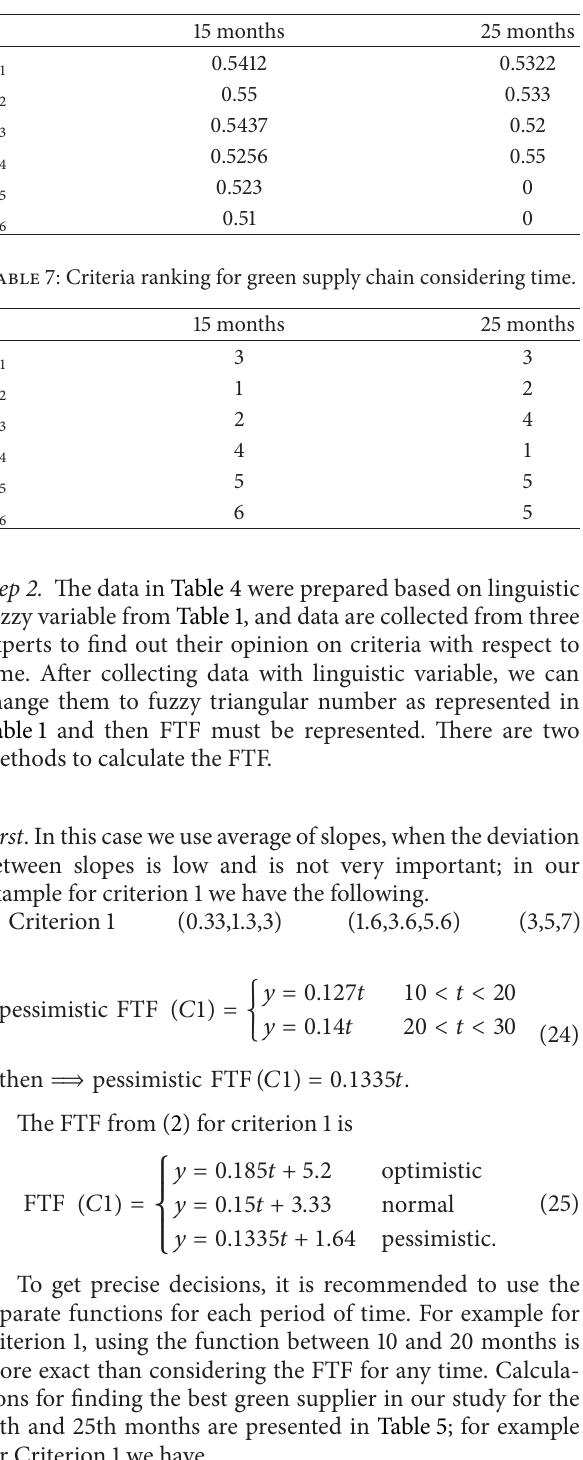
Table 6: Criteria weights using fuzzy TOPSIS considering time periods.